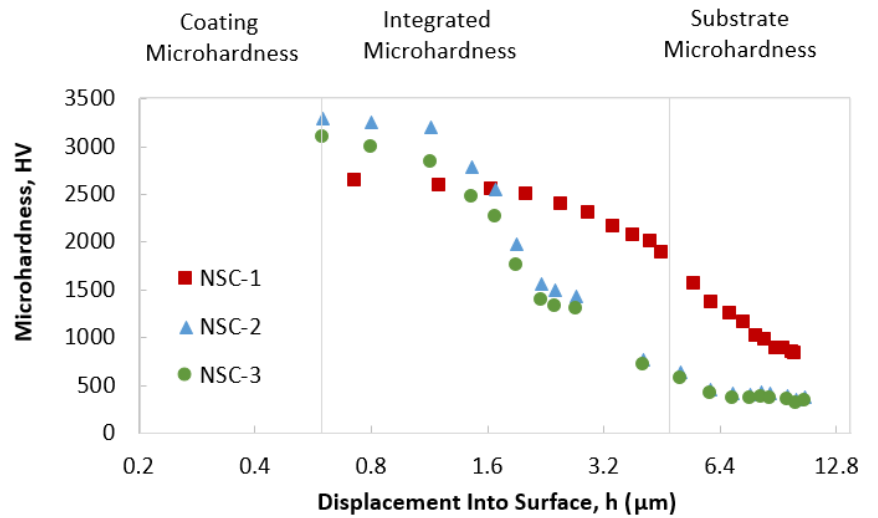
Figure 6. Microhardness dependence on displacement into the surface for the NSC samples doped with atomic element Hf (NSC-1—red, NSC-2—blue, NSC-3—green). The graph is divided into three parts characterizing coating microhardness, integrated microhardness, and substrate microhard- ness.